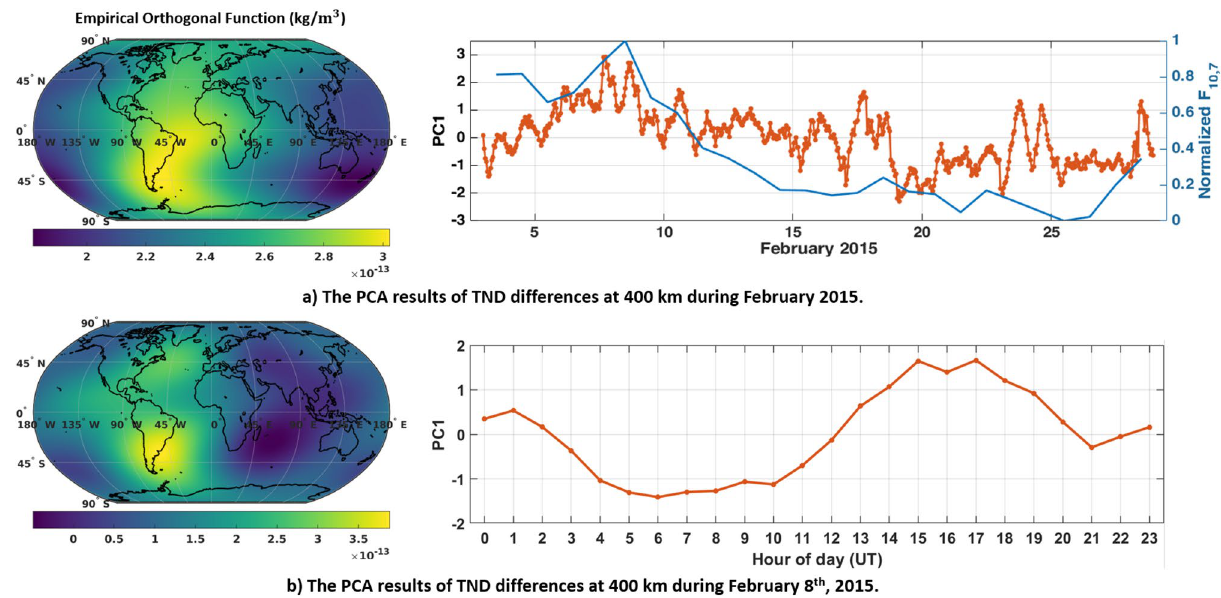
Figure 10. PCA of the TND differences between NRLMSISE-00 and C/DA-NRLMSISE-00 at 400 km during February 2015. The left plots are anomaly maps (EOFs) in terms of kg/m less time series (PCs) on the right to derive orthogonal modes. The first mode of monthly differences (on top) represents 75.55% of the total variance of TND differences and the first mode of daily differences (on bottom) mode indicates 52.34% of the variance. These plots were generated using MATLAB (version R2021a, https:// www. mathw orks.